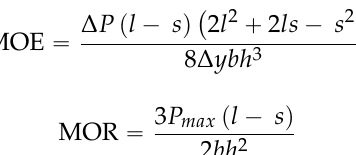
Figure 2. Cross ‐ section of the glulam specimens.